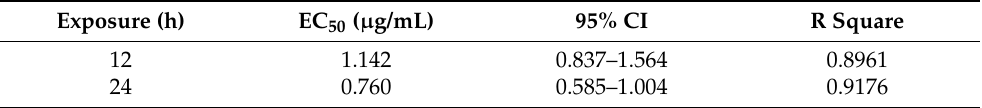
Table 3. Median effective concentration (EC 50 ) in µ g/mL of keratinocytes (HaCaT) treated with GNPs for 12 and 24 h. Confidence limits (95% CI) and goodness of fitness (R square) are also presented. Exposure (h) EC 50 ( µ g/mL) 95% CI R Square